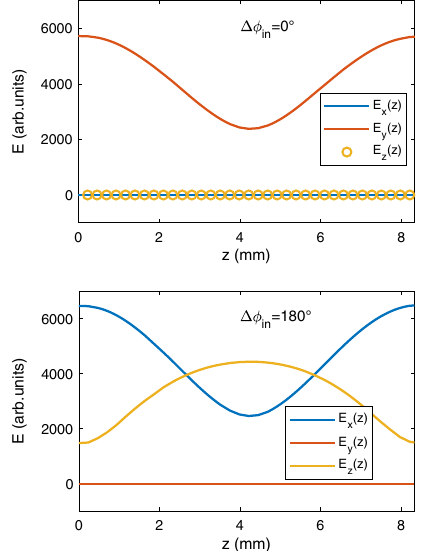
FIG. 25. E-fieldcomponentsalongalinewhichextendsbetween the points ð x 1 ; 0 ; z 1 Þ and ð x 1 ; 0 ; z 2 Þ , where x 1 is a given offset and z 1 and z 2 arethelongitudinalcoordinatesoftheiriscenters.For ¼ 0 °, on the bottom Δ ϕ ¼ 180 °. the plot on the top Δ ϕ in in sweeps from 0° to 180°. Moreover, as shown in Fig. 25, where the cartesian components of the E-field are plotted along one cell from iris to iris, ð z Þ reaches the maximum value in the middle of E z the cell where the transverse components reach their ð z Þ reaches its minimum. On the opposite, the E z minimum value for z corresponding to the iris positions where the transverse components reach their maximum value;